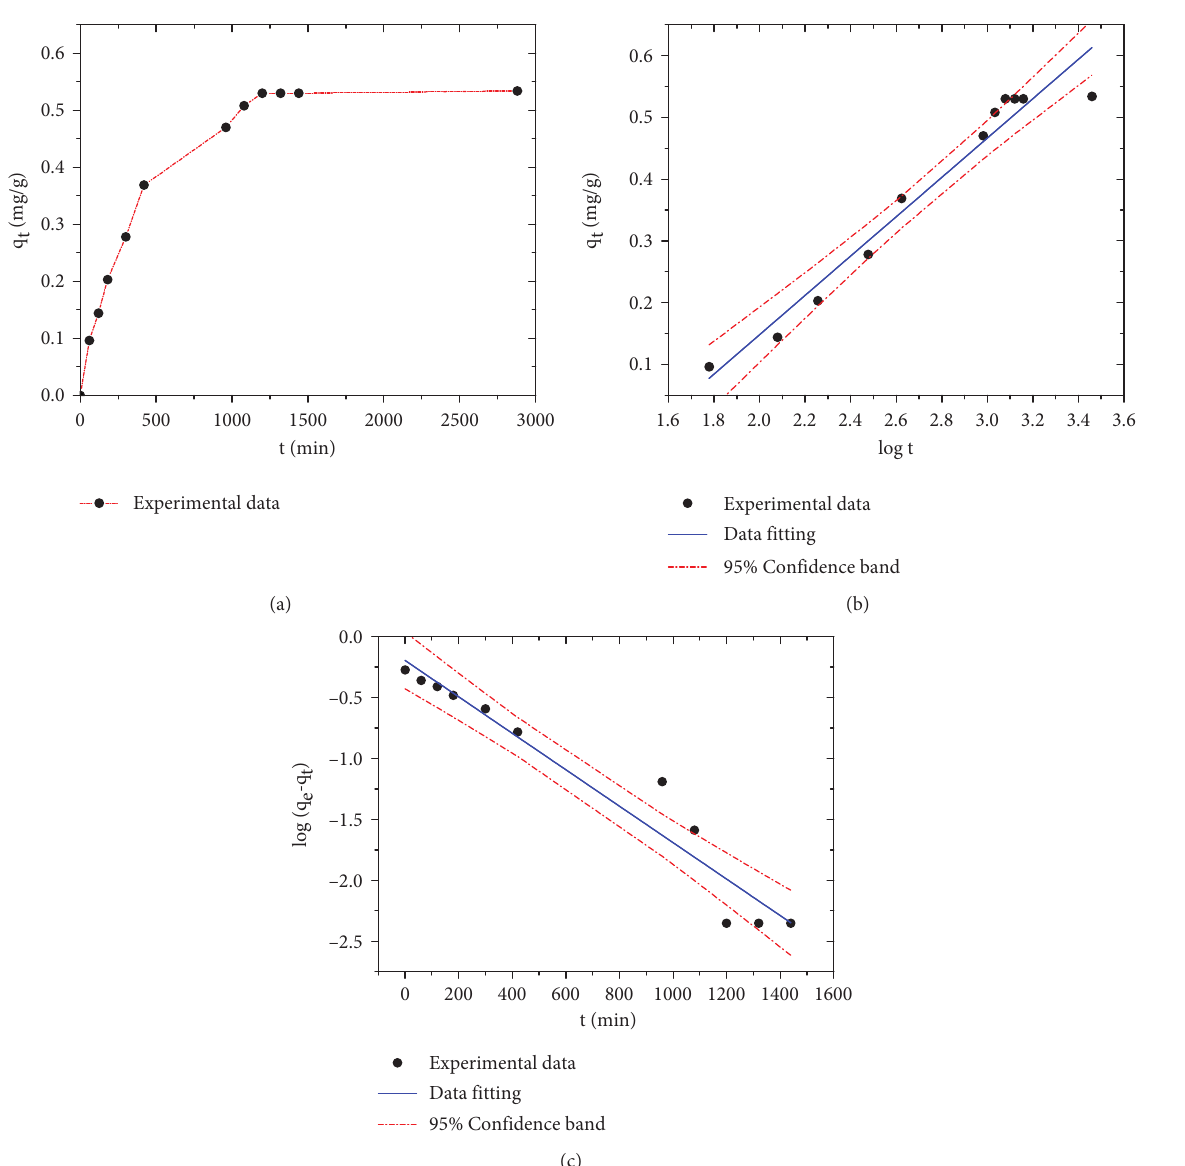
Figure 5: (a) Sorption of europium as a function of time on tausonite, using a 1 × 10 − 4 M solution of EuNO material at a constant pH. (b) Fitting of experimental data using the linearized equation of the Elovich model. (c) Fitting of experimental data of the pseudo-first-order